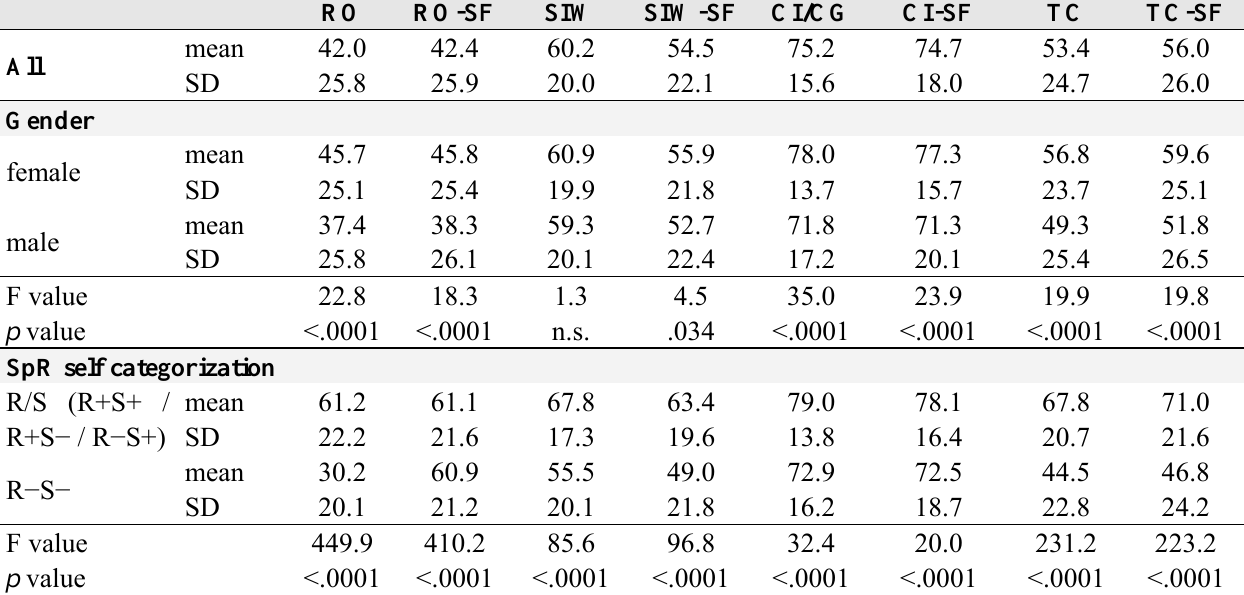
Table 6. Mean values within the German sample (n = 867).